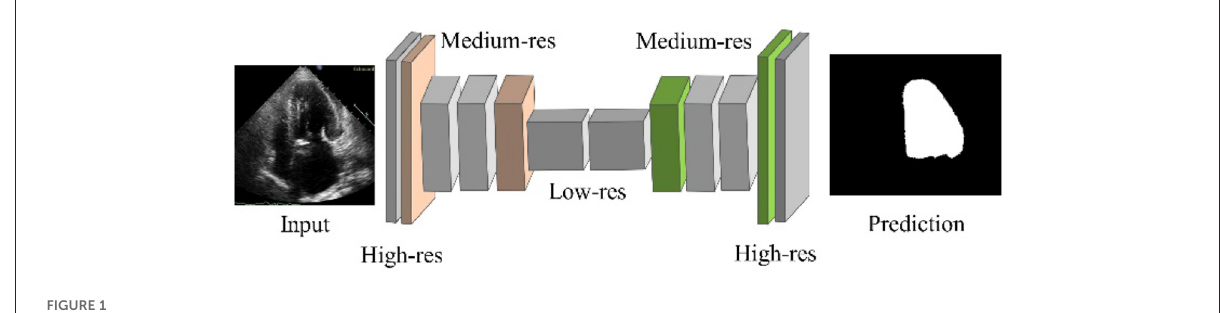
FIGURE1 FCN architecture.